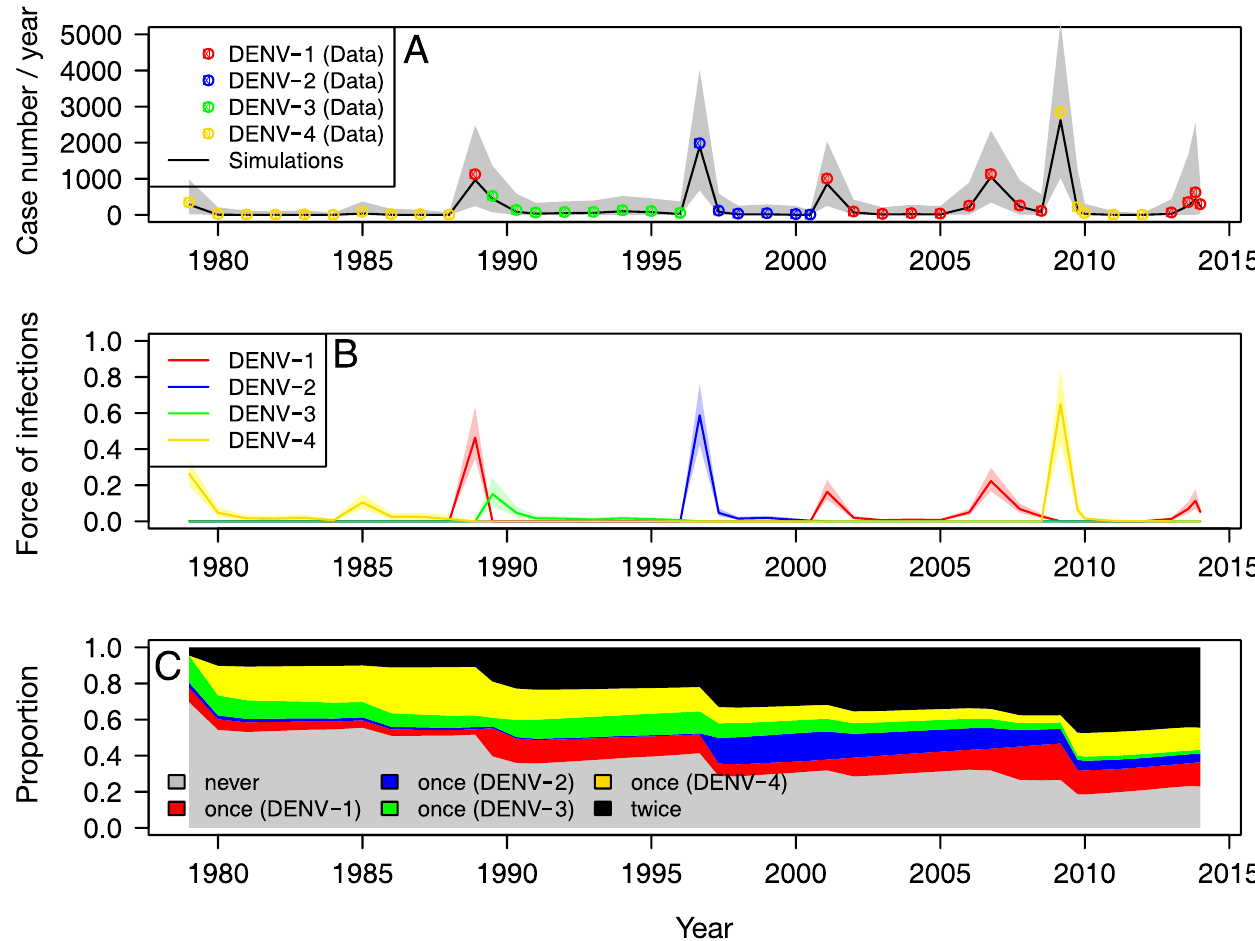
Fig 3. Estimated FOI and immunity (obtained from our model). (A) The observed (dots) and expected (line) number of cases reported annually. Shaded area represents 95%-CI. (B) Fitted FOI for the four serotypes. (C) Average immunity profile of the population. The grey area shows the fraction of the population that were never infected, averaged over age groups. Red, blue, green, and yellow areas represent the fraction of the population who have been infected once by a serotype i (before the time we consider), where i = 1,2,3,4 correspond to red, blue, green, yellow, respectively. Black area represents the fraction of the population who have been infected more than once (before the time we